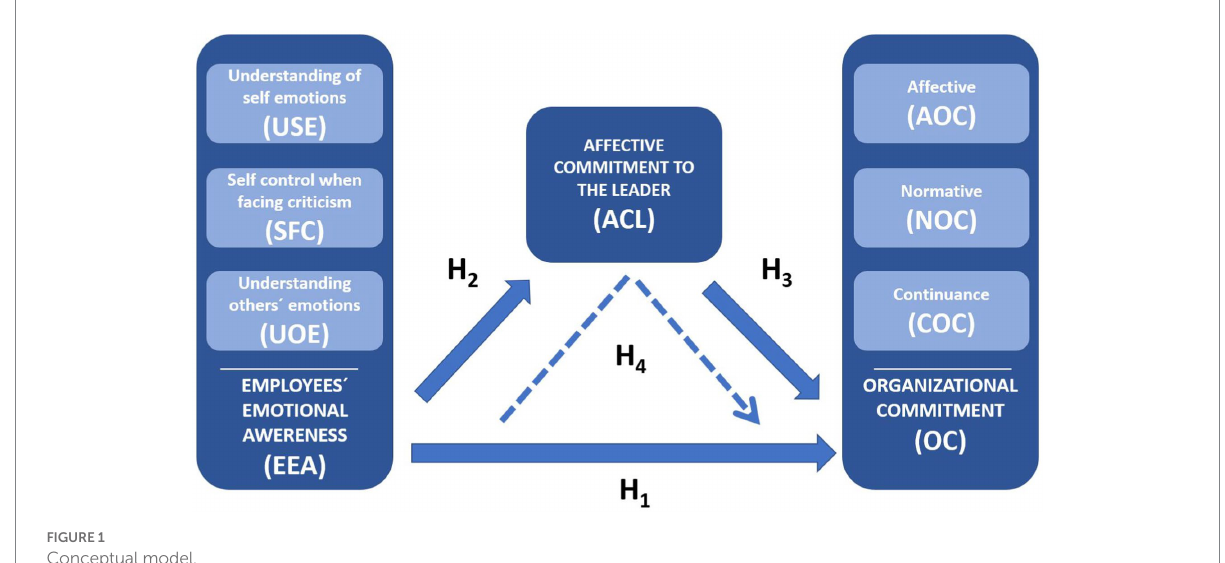
FIGURE 1 Conceptual